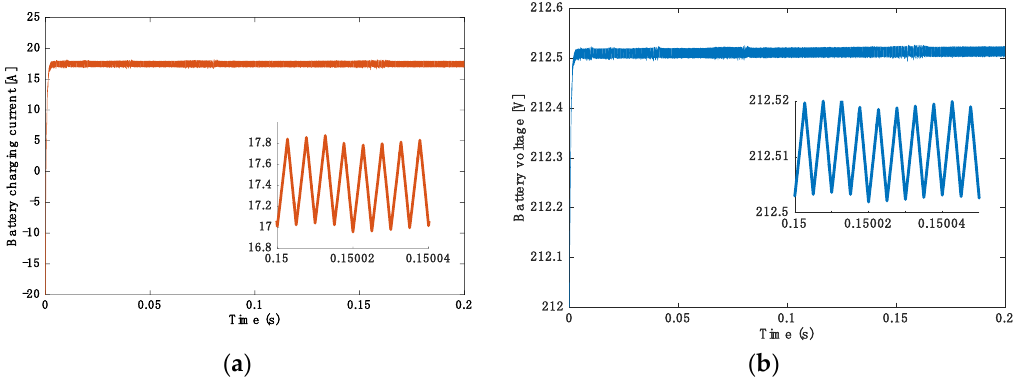
Figure 12. Grid-to-vehicle (G2V): ( a ) Battery charging current; ( b ) Battery voltage.